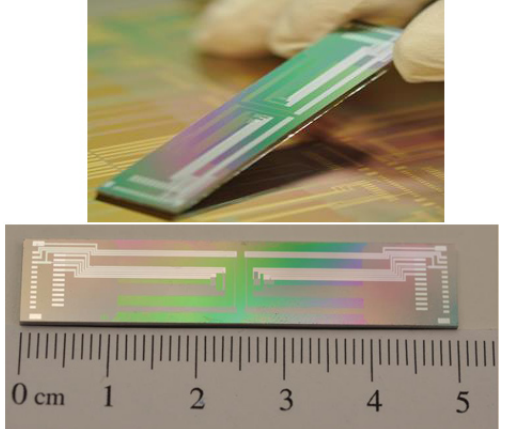
Figure 6. The sensor inlay cut-out from the wafer after fabrication (50 × 10 × 2mm).